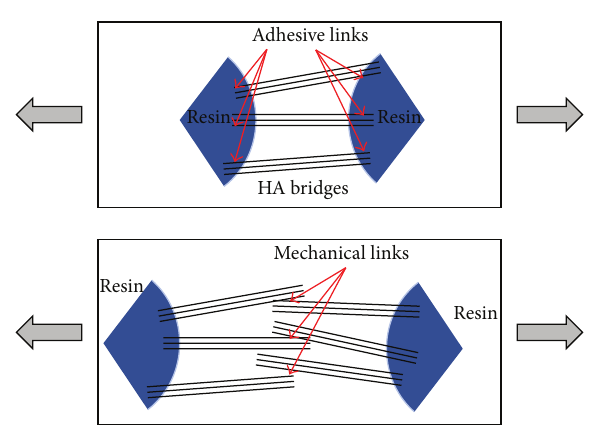
Figure 8: The mechanisms of transfer of the stresses between micelles.